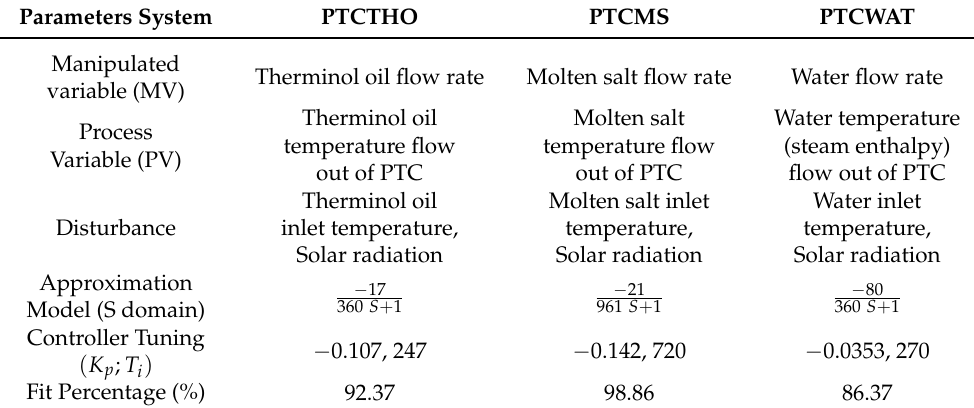
Table 3. Control parameters for different